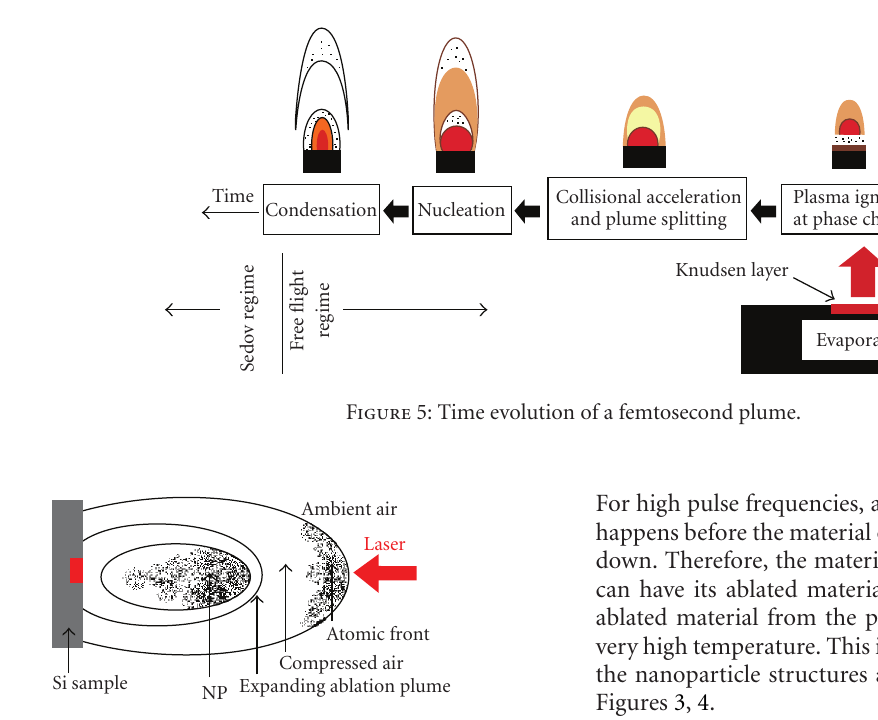
Figure 6: Constituents of the femtosecond plume.